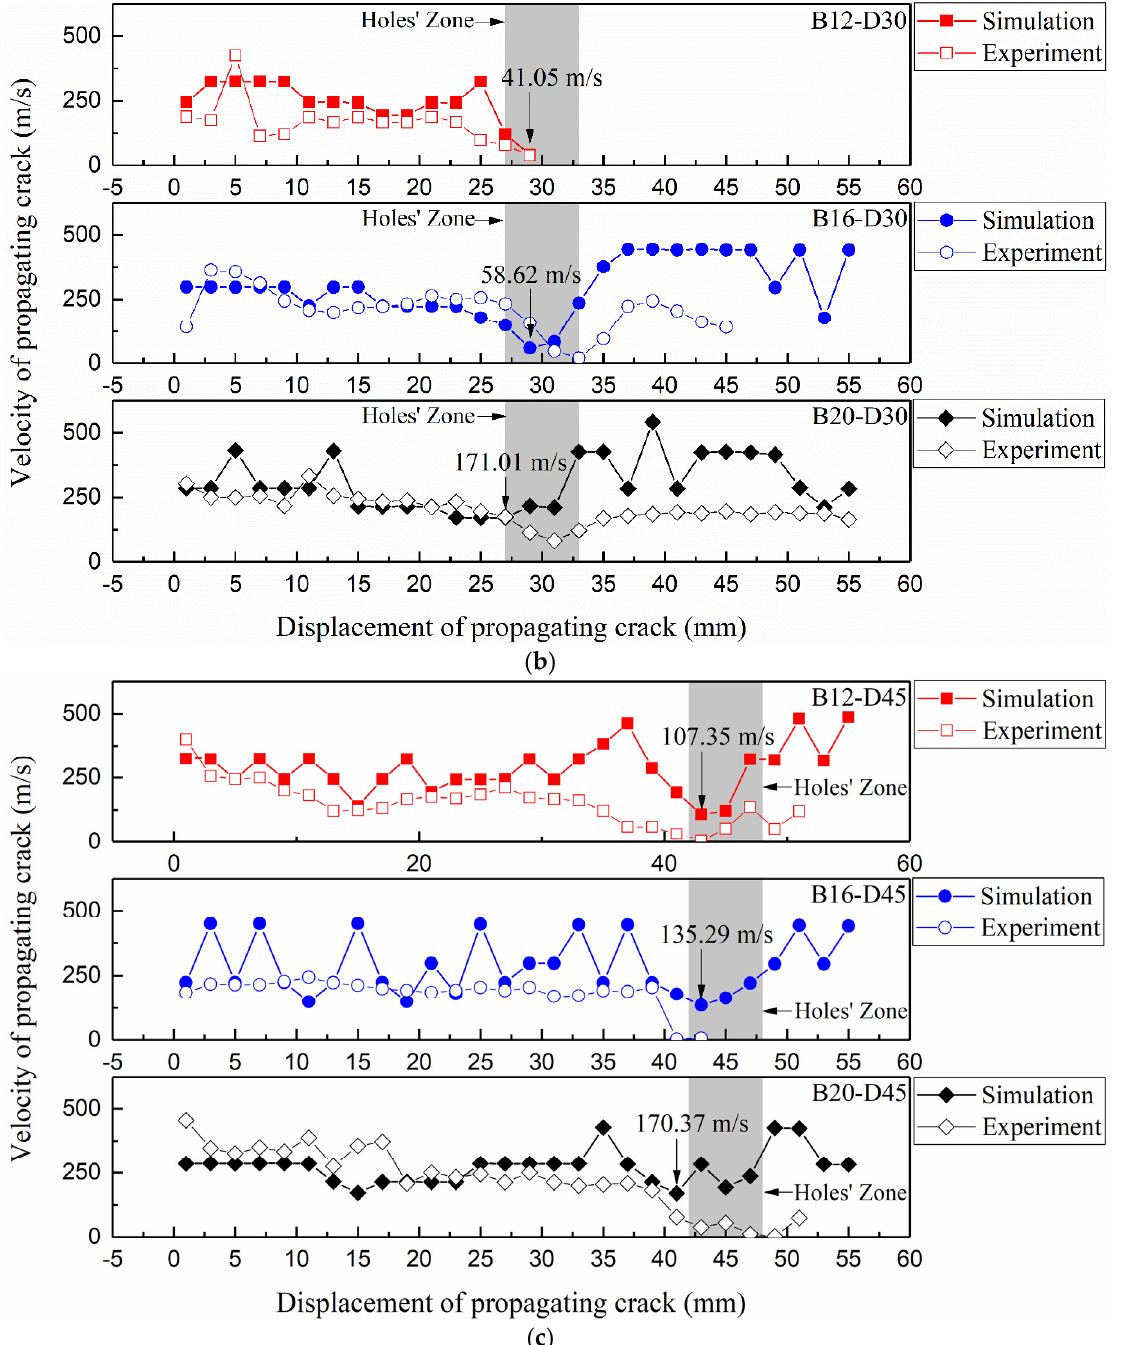
Figure 12. Crack propagation velocity curves of different types of specimens using AUTODYN. ( a ) Specimen with constant D = 15 mm. ( b ) Specimen with constant D = 30 mm. ( c ) Specimen with constant D = 45 mm.